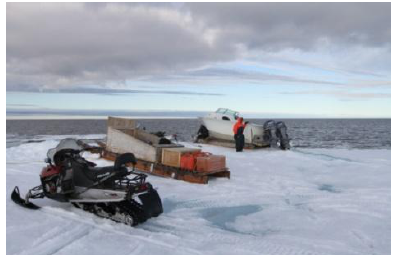
Figure 11 : In position at edge of ice shelf